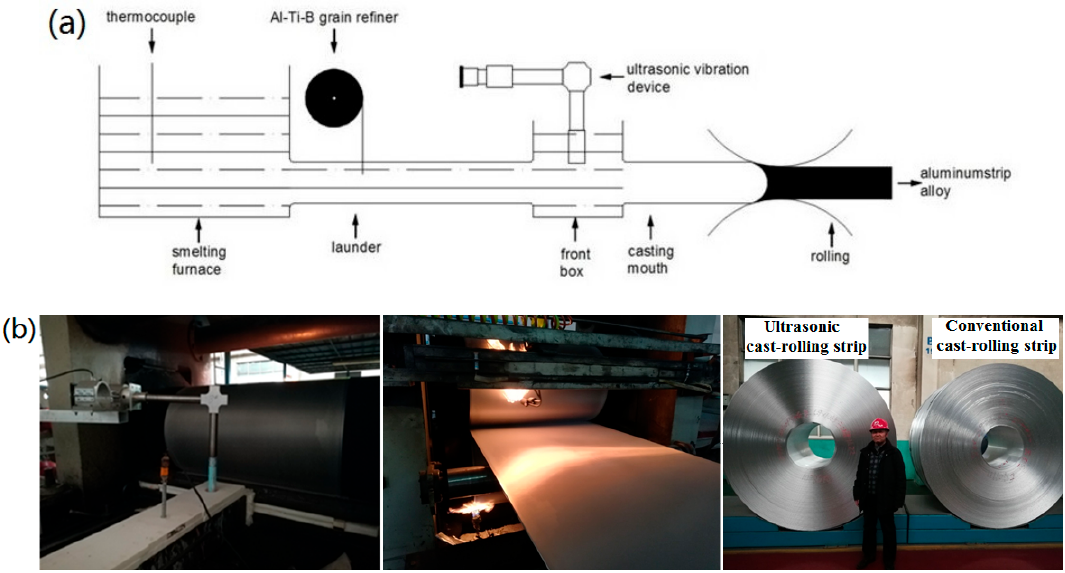
Figure 2. Schematic ( a ) and field picture ( b ) of the continuous casting and rolling of the 1060 aluminum alloy.